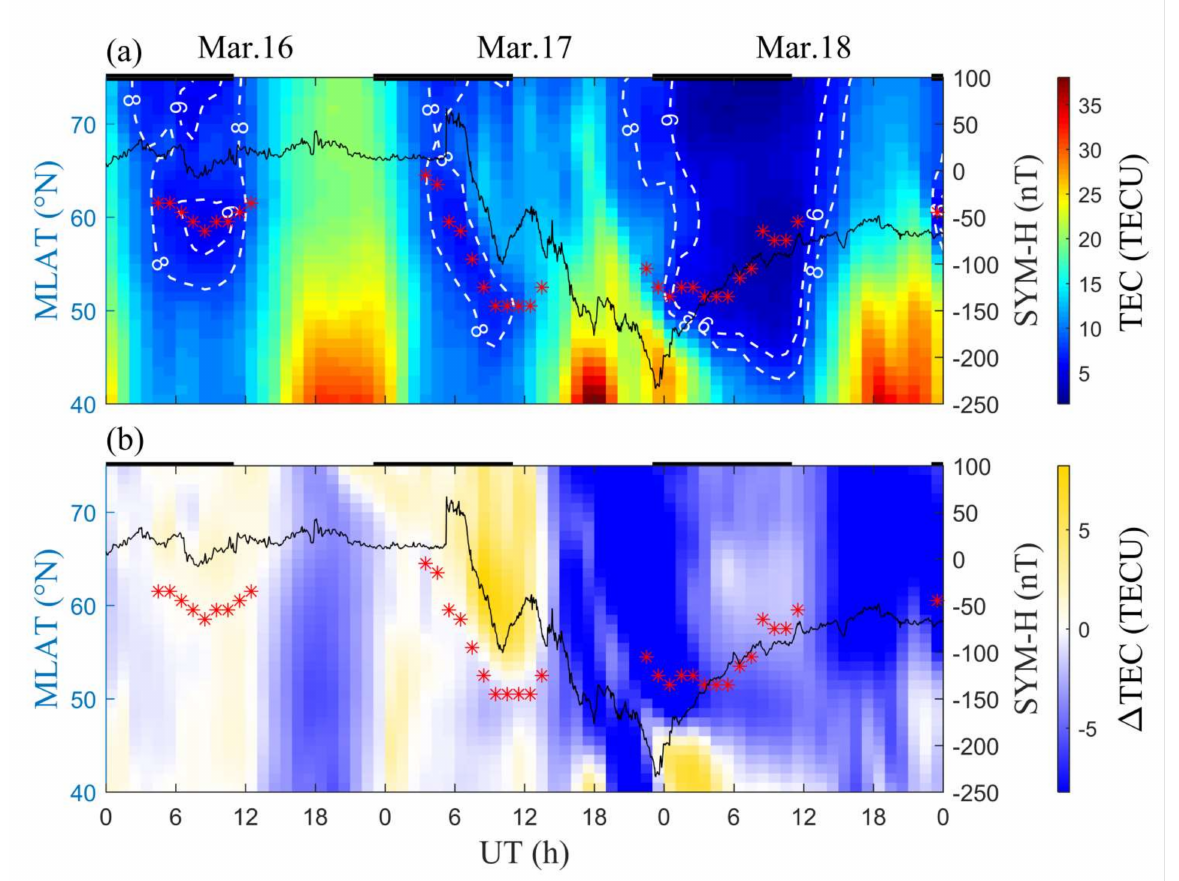
Figure 7. Ionospheric storm variations of ( a ) TEC and ( b ) TEC absolute deviations from the reference for American sector during the 2015 March storm. The contour levels indicate the 4, 6, and 8 TECU values. The red asterisks indicate the mid-latitude trough position. The black line shows the SYM-H variations. The local nighttime in the American sector is marked with thick black line